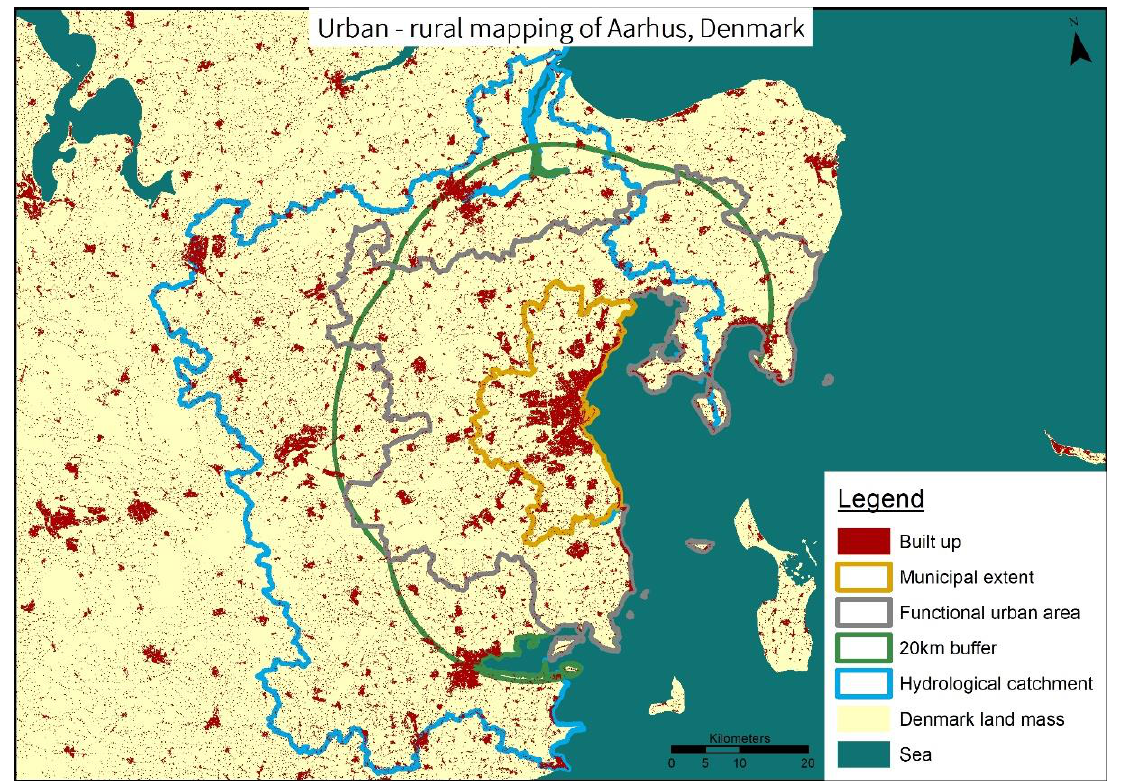
Figure 5. Different extents of the urban area, including the functional urban area, according to the EC [66] and boundaries not set by humans, e.g., watershed or airshed, and a 20 km buffer zone around the municipal border.